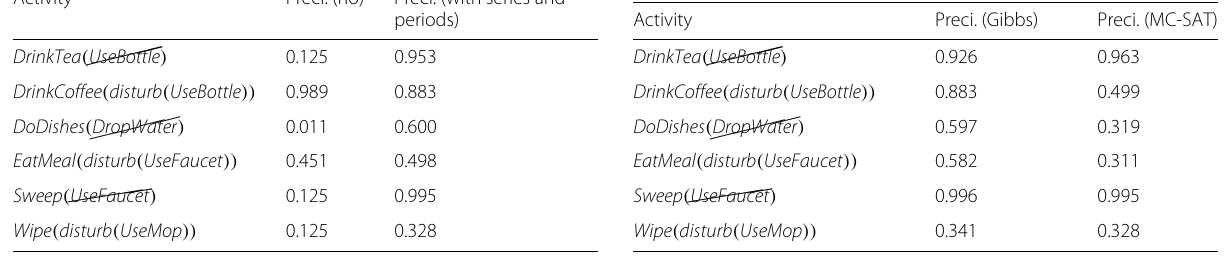
Table 4 The missing data or wrong data disturbance situation’s Table 6 The missing data or wrong data disturbance situation’s inference precision of different activities inference precision of different Activity Preci. (no) Preci. (with series and periods)